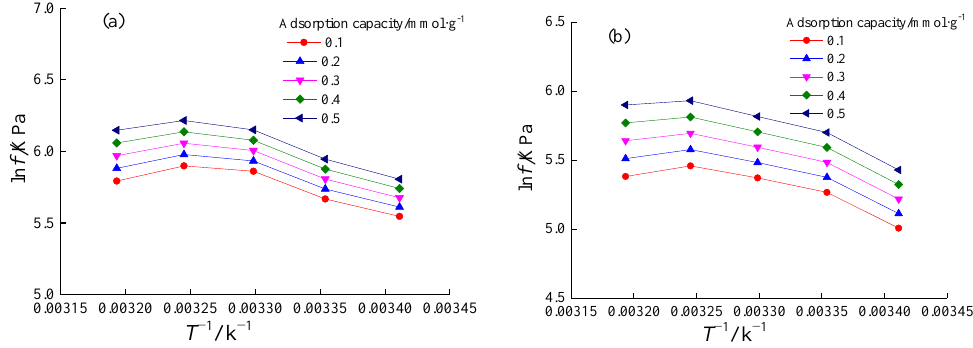
Figure 9. ln f -T − 1 of adsorption process in the desorption experimental: ( a ) vitrain; ( b ) durain. Figure 9. ln f -T −1 of adsorption process in the desorption experimental : ( a ) vitrain; ( b ) durain. Table 10. Isosteric adsorption heat during methane Table 10. Isosteric adsorption heat during methane desorption.